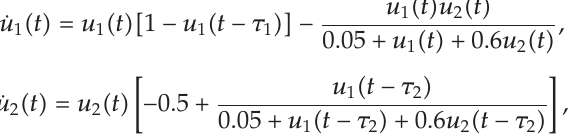
Figure 1: Trajectory portrait and phase portrait of system (cid:2) 4.1 (cid:3) with τ 1 (cid:6) 0 , τ 2 (cid:6) 1 . 5 < τ 2 positive equilibrium E 0 (cid:2) 0 . 3038 , 0 . 4230 (cid:3) is asymptotically stable. The initial value is (cid:2) 0.2,0.2 (cid:3)